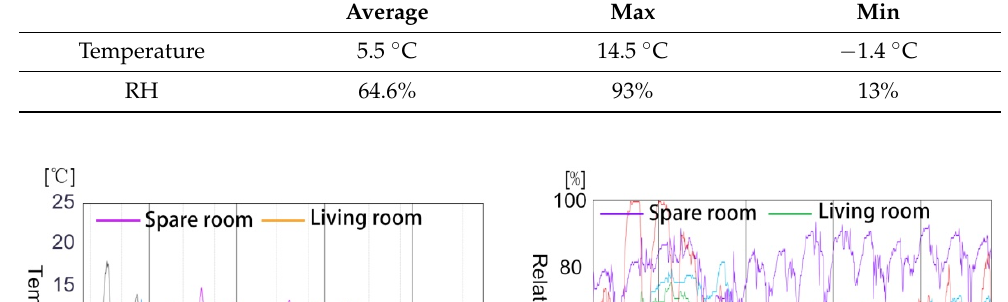
Table 10. Statistics of indoor environmental parameters for W3.